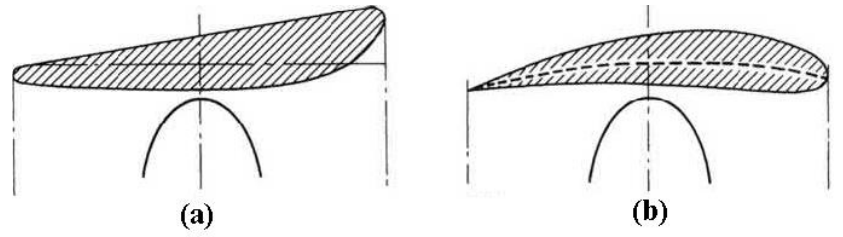
Figure 18. Duct types: ( a ) accelerating duct and ( b ) decelerating duct.